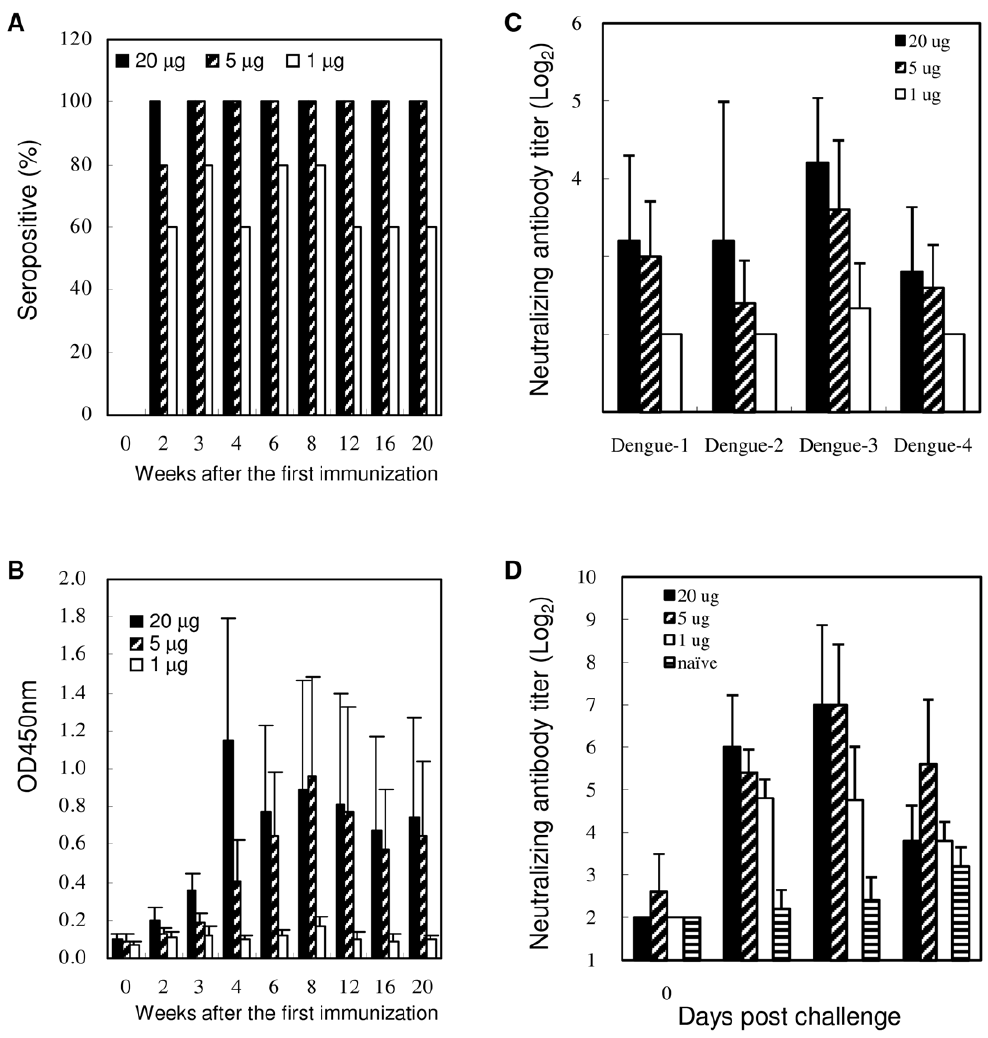
Figure 5. A single-dose of LcED III is able to induce cross-neutralizing antibodies and memory neutralizing antibodies. BALB/c mice (n=5) were immunized once subcutaneously with 1, 5, or 20 m g of LcED III. (A) Seroconversion rates and (B) the optical density of serum samples at a 2500-fold dilution versus time after immunization are plotted. (C) Sera samples were collected four weeks after the immunization. The neutralizing antibody titer ofthe seraineachmousewas determined byFRNT.(D) Immunizedmice werechallengedintraperitoneallywith5 6 10 6 FFUoflivedengue-2 virus at week 28 post-priming. Sera obtained from naı¨ve mice inoculated with live dengue-2 virus served as controls. Serum samples were collected in each mouse to evaluate neutralization of the infectivity of dengue virus by FRNT. The neutralizing antibody titer was calculated as the reciprocal of the highest dilution that resulted in a 40% reduction of FFU compared to that of a control that consisted of treatment with virus and pre-immunization sera.